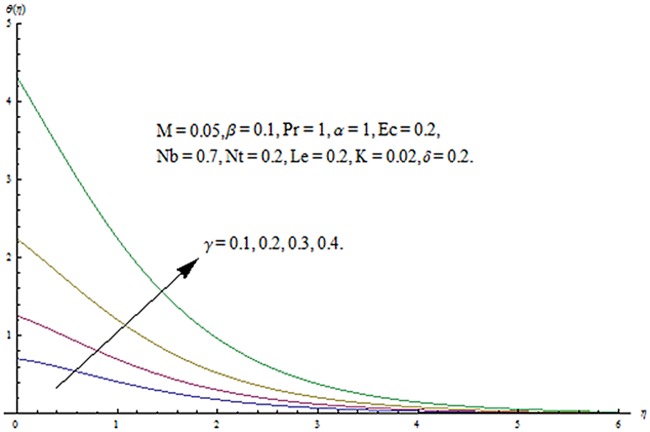
Influence of γ on θ.